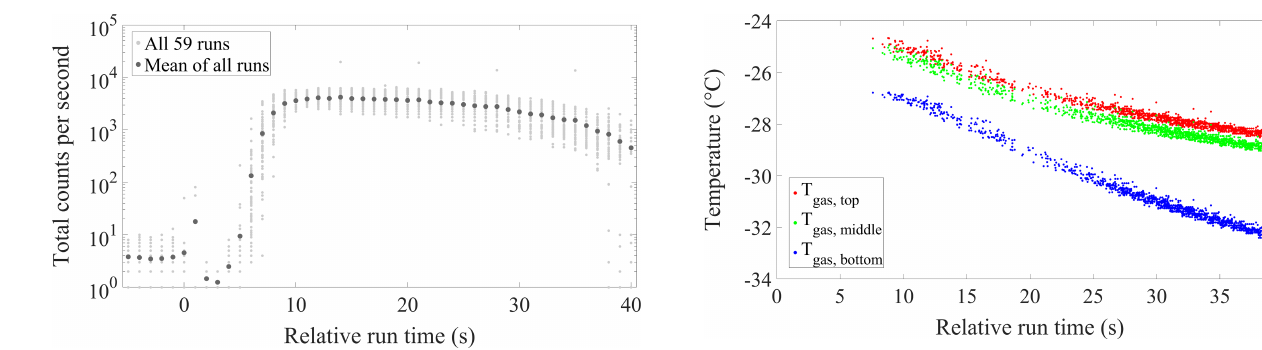
Figure 4. Total number counts measured with PINE-1A in 1s time intervals of 59 consecutive runs during the HyICE field campaign (operation 64 on 25 March 2018). The measured count rates are plotted as a function of time relative to the start of the expansion. The small grey dots in this figure show the OPC count rates of indi- vidual runs, and the bigger black circle shows the mean over all 59 runs of this operation. Before the start of the expansion, only larger aerosol particles are measured. The sharp increase after about 6s of expansion is due to CCN activation of the aerosol particles in the chamber and the growth of droplets.